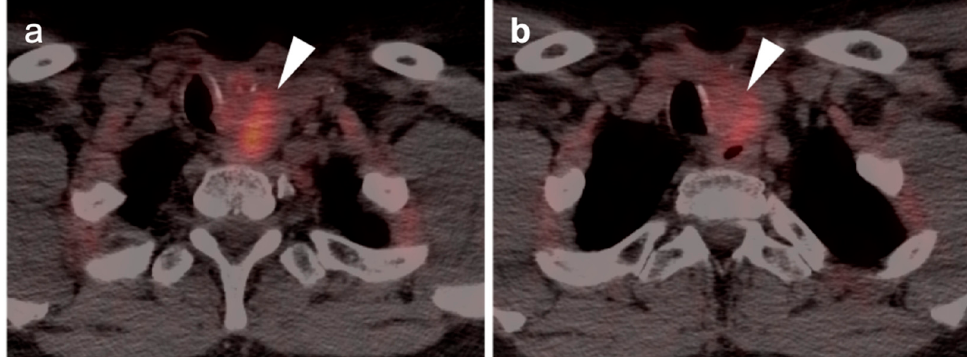
Figure 33. Recurrent medullary thyroid cancer. ( a , b ) FDG PET ‐ CT axial images demonstrate a mild ‐ moderately hypermetabolic mass (white arrowheads) in the left thyroid bed in a patient with a ris ‐ ing serum calcitonin level 5 years following total thyroidectomy for medullary thyroid cancer.